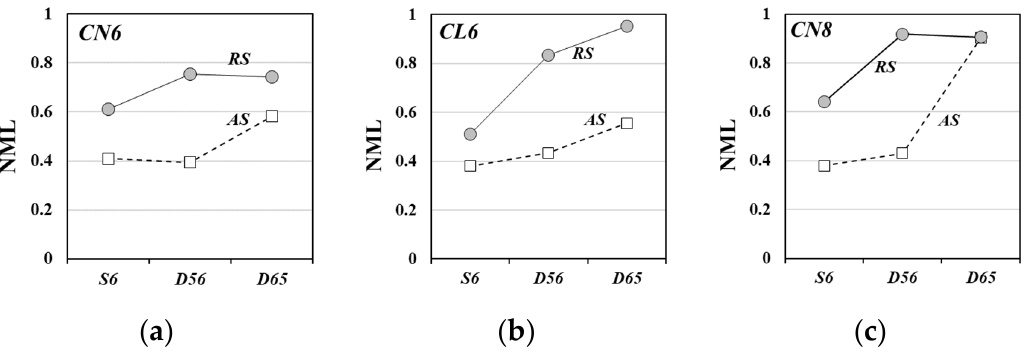
Figure 5. NML values of the welds produced with the tools: ( a ) CN6, ( b ) CL6, ( c ) CN8.